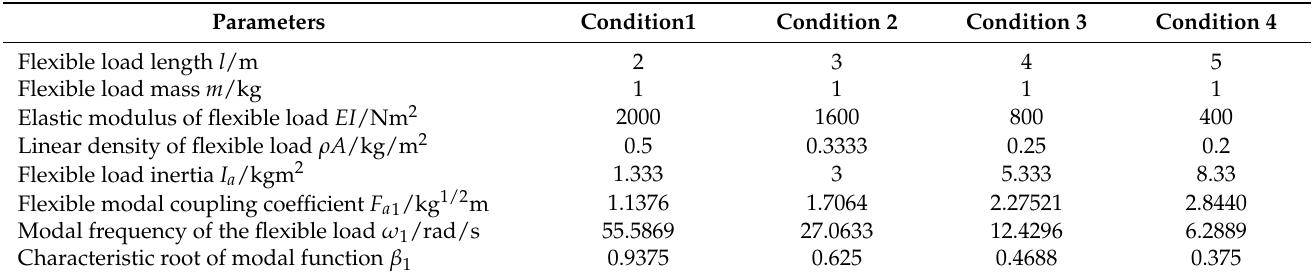
Figure 10. The influence of the damping coefficient of poles on the rotation angle. ( I ) Condition1. ( II ) Condition2. ( III ) Condition3. ( IV ) Condition4. Table 1. Parameters of flexible